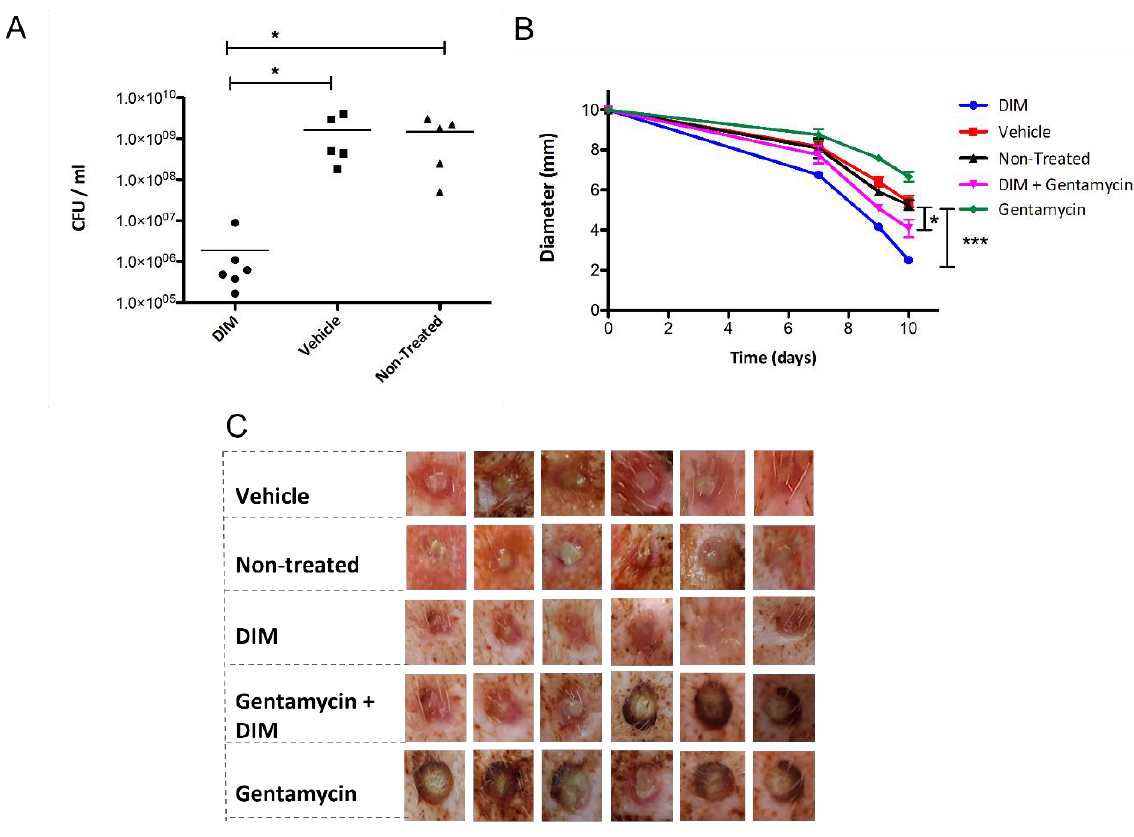
Figure 6. Quantification of P. aeruginosa PA01 strain isolated from the wound-associated biofilm. Biofilms were allowed to develop for 48 h before the formulated cream treatments were applied. ( A ) Punch biopsies were collected on day 10 post-infection, and the CFU mL −1 was determined. Asterisks indicate significant differences when compared to vehicle or non-treated groups (independent samples t -test; * p < 0.05; *** p < 0.001). Wound healing in porcine model infected with P. aeruginosa PA01. ( B ) Mean diameters of the non-treated wound and wounds treated with DIM, gentamycin, vehicle, and a DIM-gentamycin combination on day 10. Values are the averages of the results for six measurements and error bars denote standard deviations. Student t -test calculated p -values of <0.05 were considered significant. ( C ) Healing of 10-mm diameter, full-thickness excision wounds on the back of domestic swine (crossbreed of Landrace & Large White genetic strains) was monitored using digital photography. Representative photos taken on day 10 are shown. Data are reported in mean scores ± SD (*).